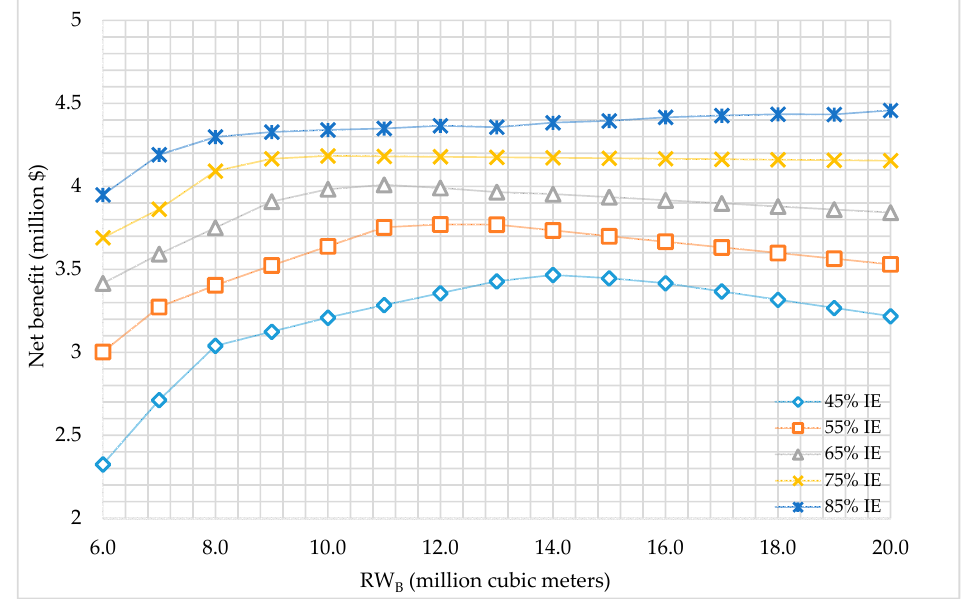
Figure 3. Total net benefit (million $) predicted using reclaimed water type B (RW B ) with five different irrigation efficiencies (IEs).